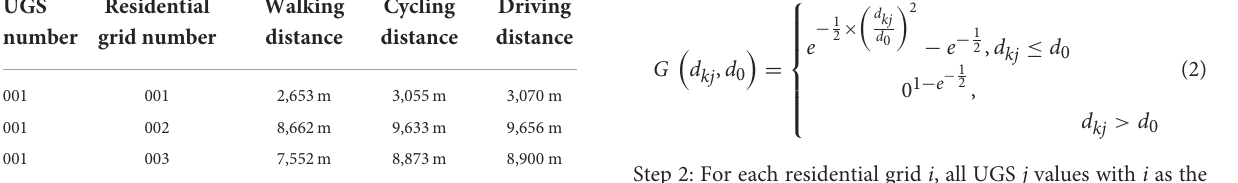
TABLE 4 Sample data of the travel distance between UGS and residential areas.